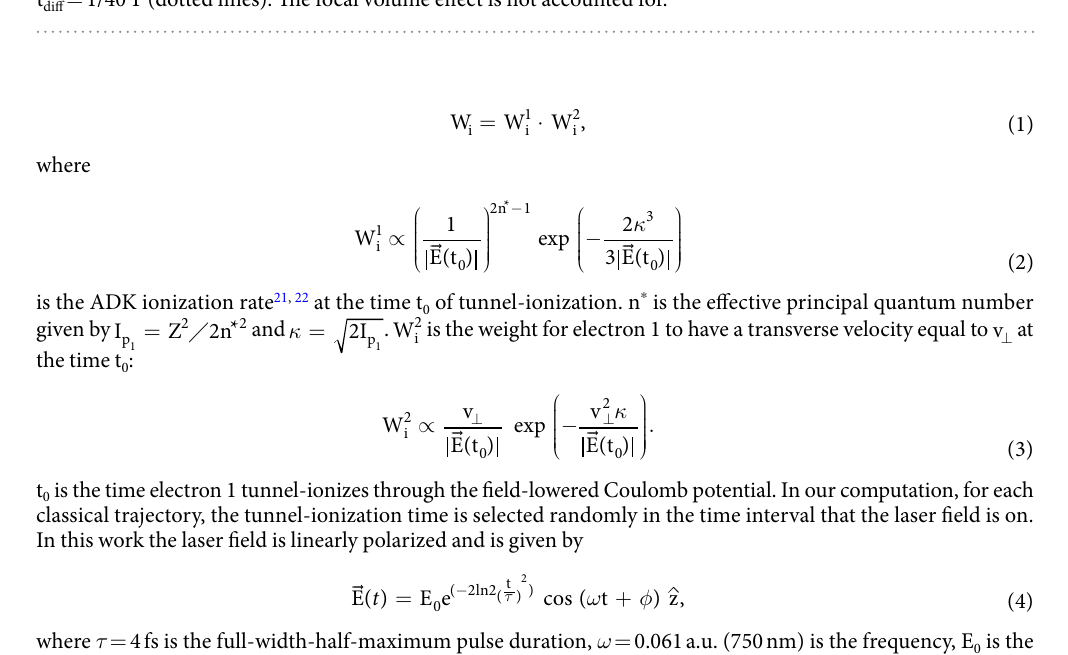
Figure 2. Percentage contribution of the direct (blue circles) and the delayed (red triangles) pathways of double ionization as a function of the laser intensity for t diff = 1/10 T (solid lines), t diff = 1/20 T (dashed lines) and t diff = 1/40 T (dotted lines). The focal volume effect is not accounted